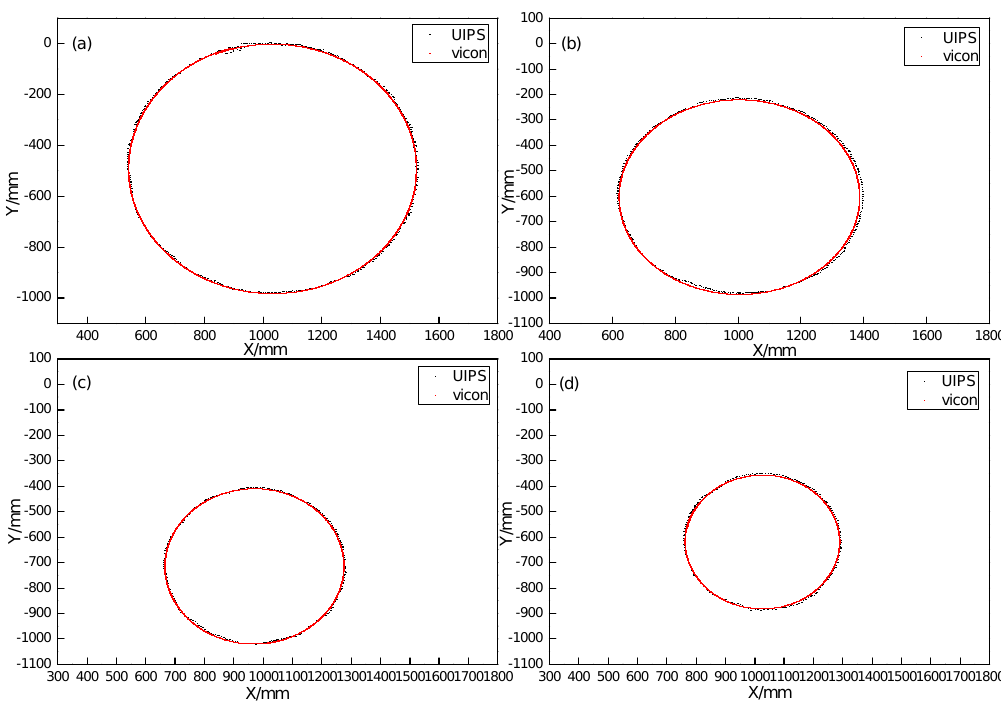
Figure 13. The comparison of the robot motion with different radii circular trajectories from ( a – d ). The position data sampling rate from vicon is much greater than that of